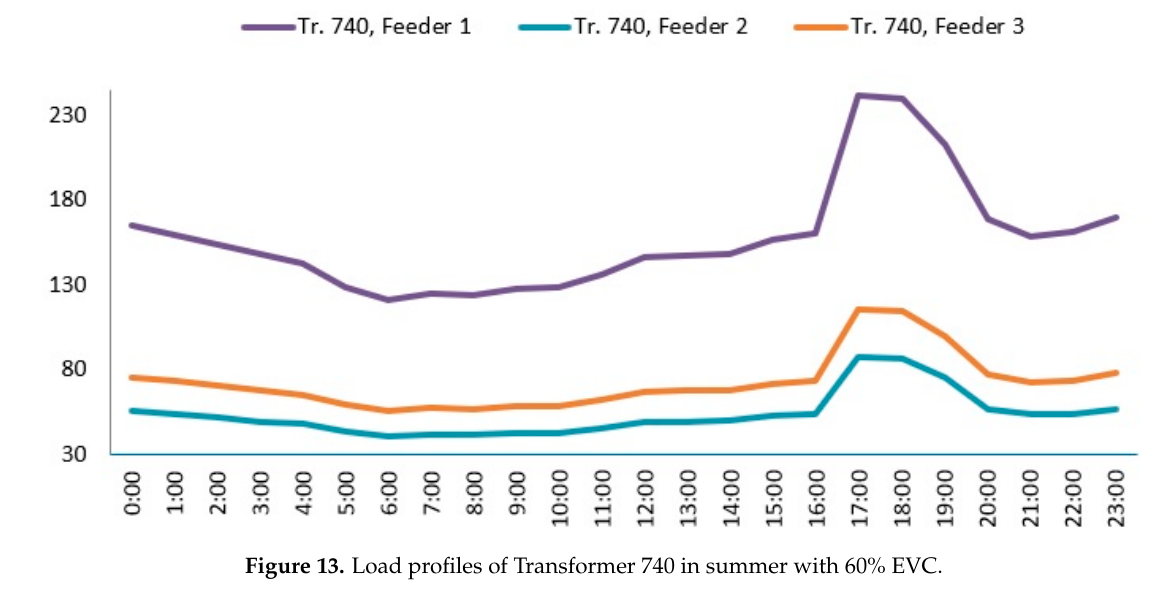
Figure 13. Load profiles of Transformer 740 in summer with 60% EVC.